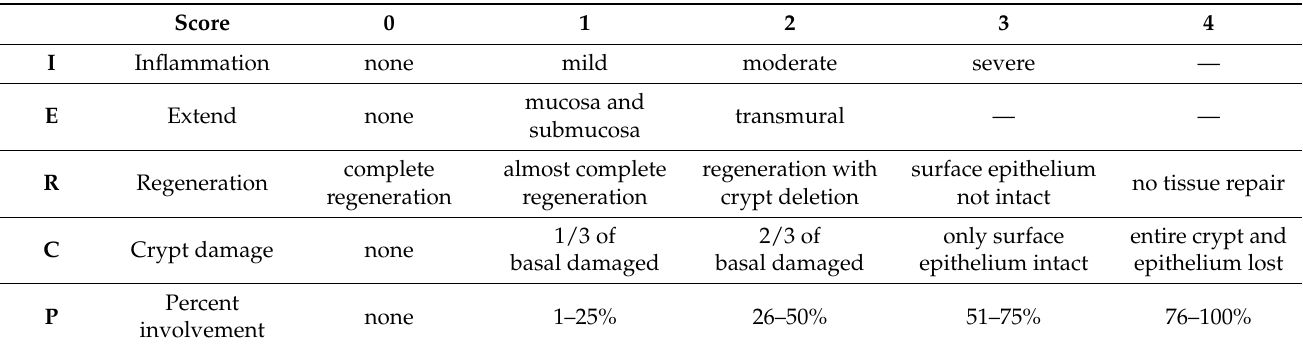
Table 1. Inflammation score calculation